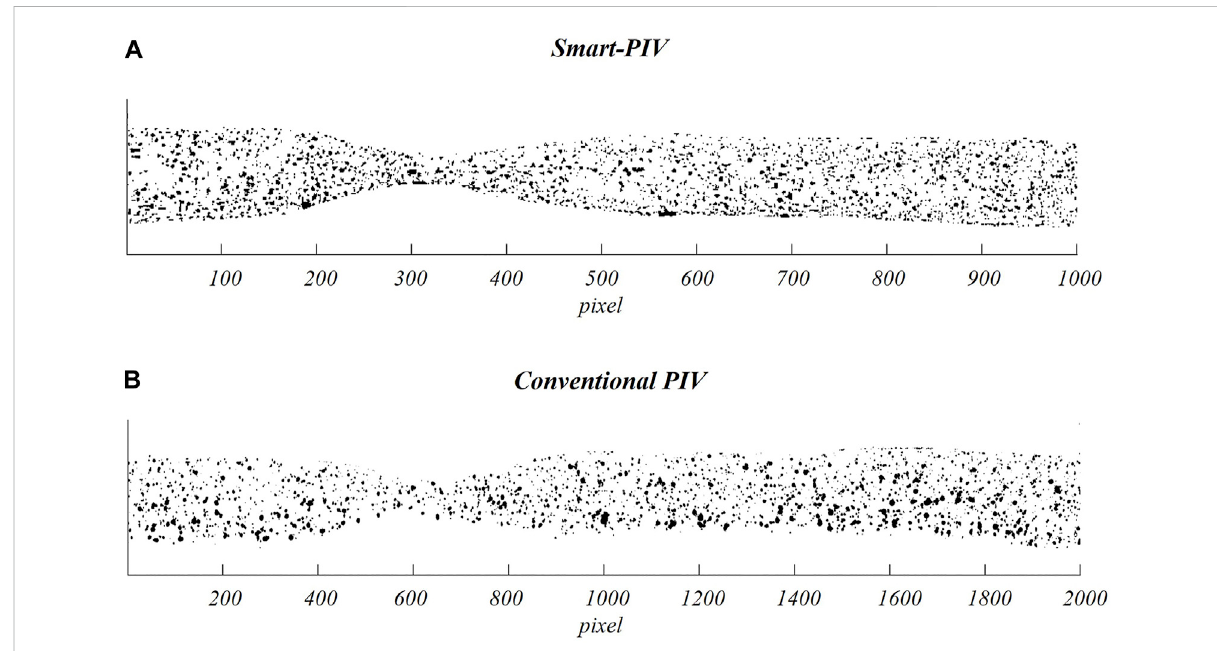
FIGURE 4 Examples ofpre-processedimages(i.e.,aftersubtractionofthemeanintensityvalueofthePIVimagesequence)acquiredonthestenosedLAD phantom adopting smart-PIV (A) and conventional PIV (B) systems.